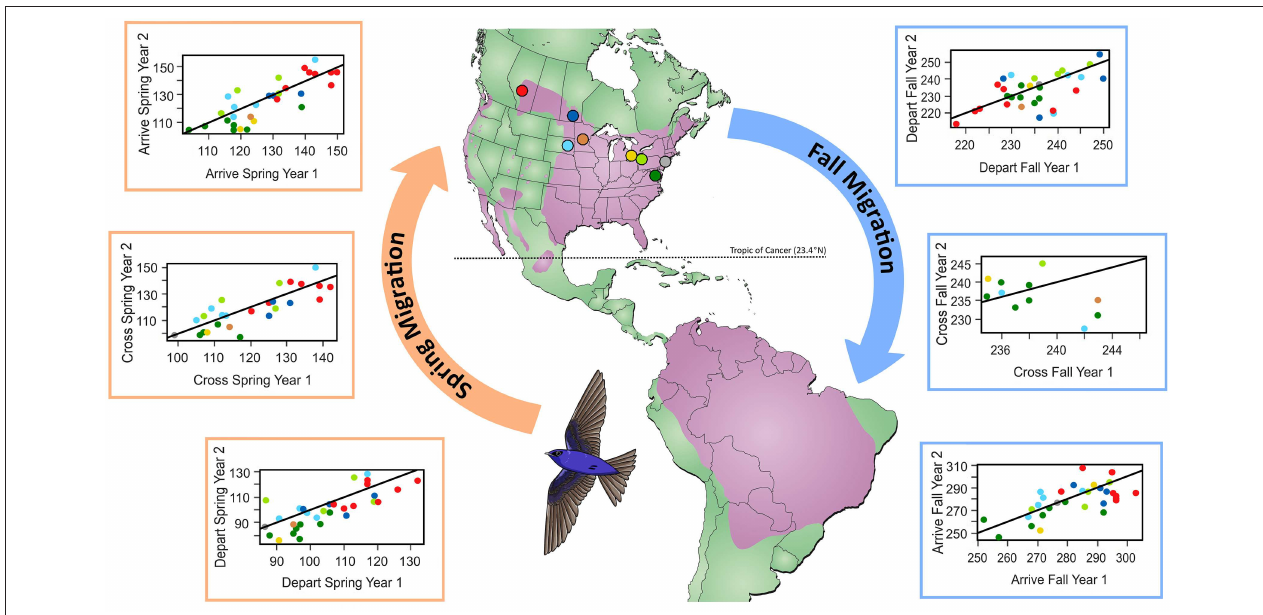
FIGURE 1 | Comparison of migration timing (day of year) at the individual level for the first vs. second year of tracking. Colors show breeding locations where geolocators were retrieved and correspond to points indicated on the map. Line indicates 1:1, where points below the line indicate earlier migration in year two. The map shows the year-round purple martin range in purple ( Brown and Tarof,